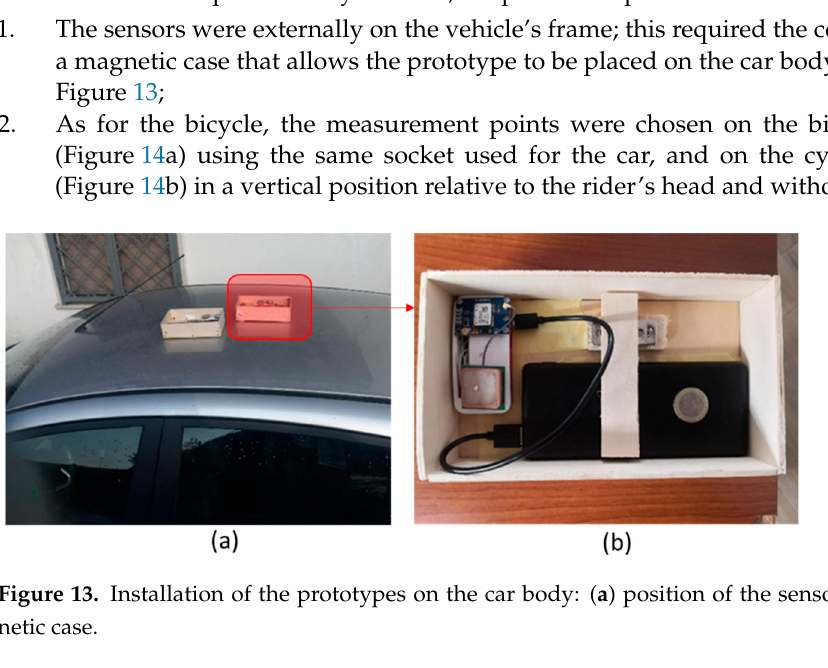
Figure 13. Installation of the prototypes on the car body: ( a ) position of the sensor and ( b ) magnetic case.